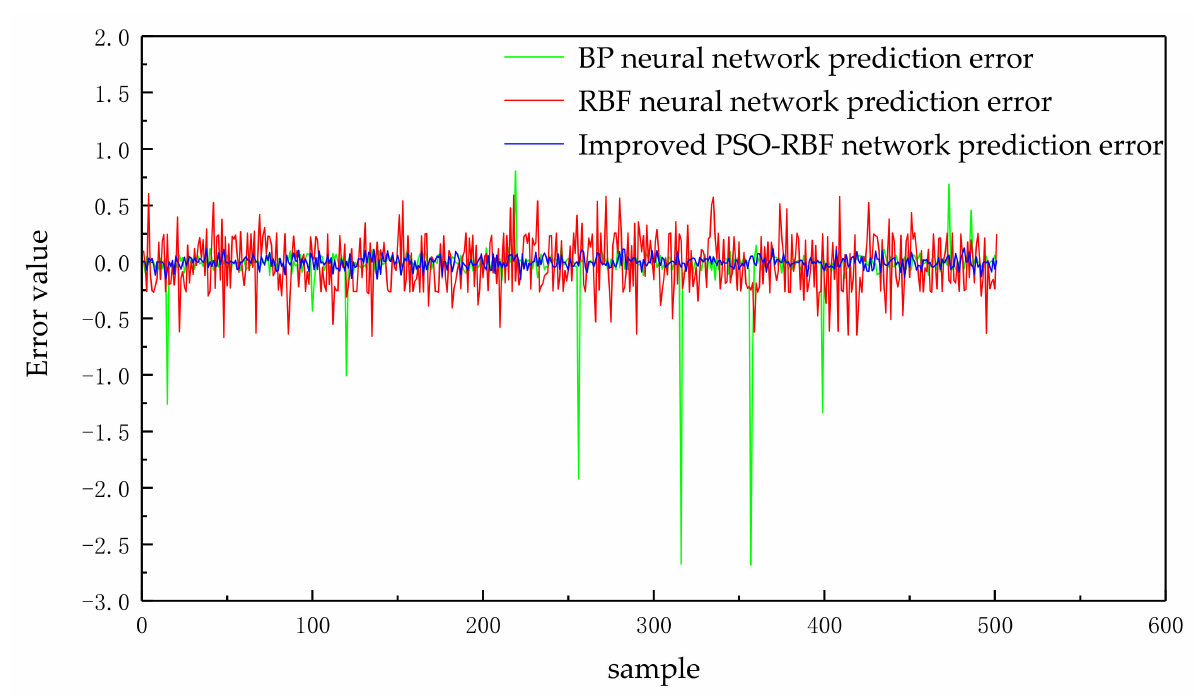
Figure 10. Error curves for different prediction